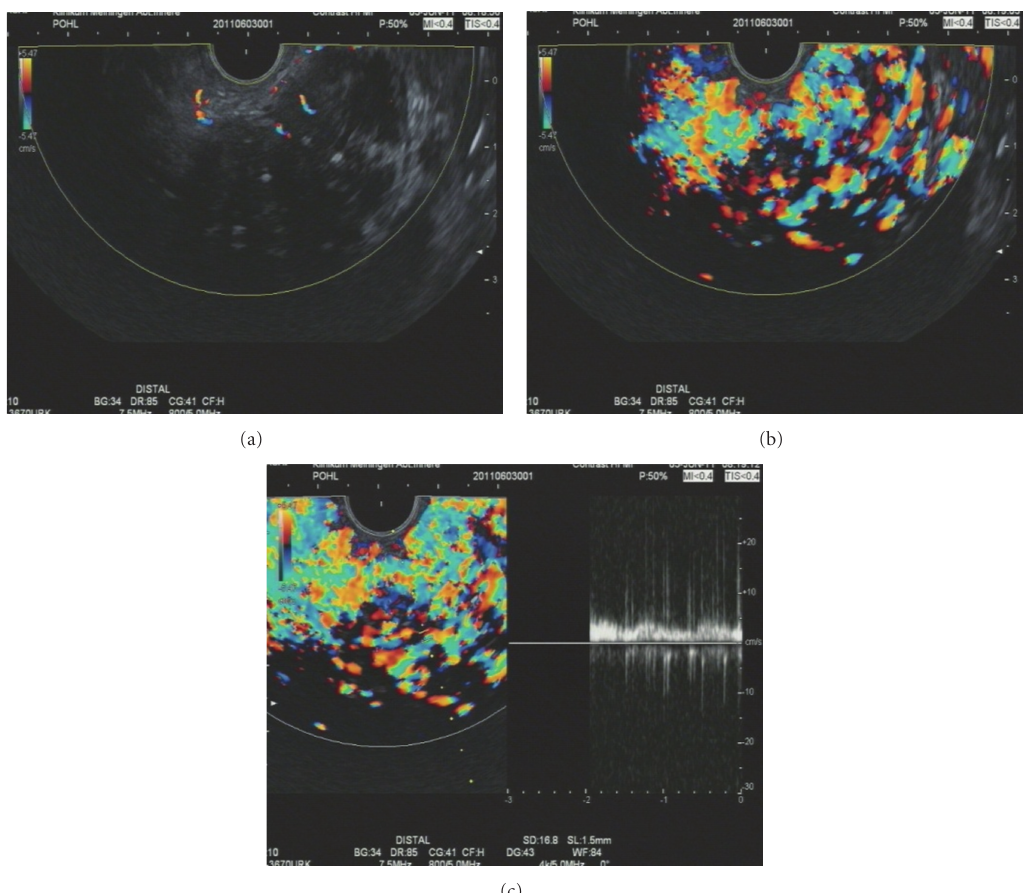
Figure 1: Contrast-enhanced high mechanical endoscopic ultrasound in a patient with chronic pancreatitis: (a) lesion before contrast enhancer injection the lesions is visible within the colour doppler window as a nearly black area; (b) Lesion after contrast enhancer influx (4.5mL Sonovue) with a visible netlike vessel system the rich vessel system is visible mostly on the right side of the picture with di ff erent colours; (c) pw-Doppler analysis of the vessels with a clear venous signal; on the right half of the picture a laminar flow is displayed as a nearly flat white bark.